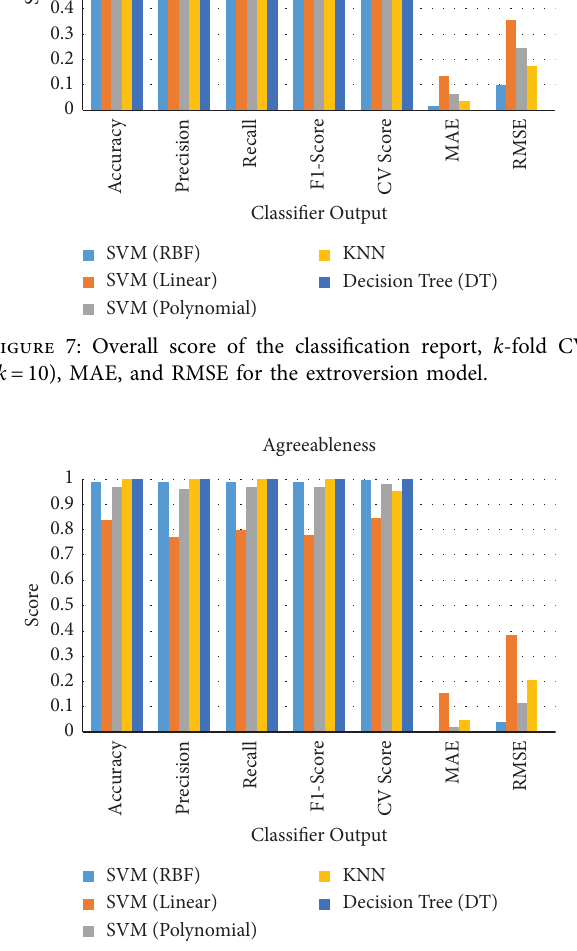
Figure 6: Overall score of the classifcation report, k -fold CV ( k � 10), MAE, and RMSE for the openness to experience model.